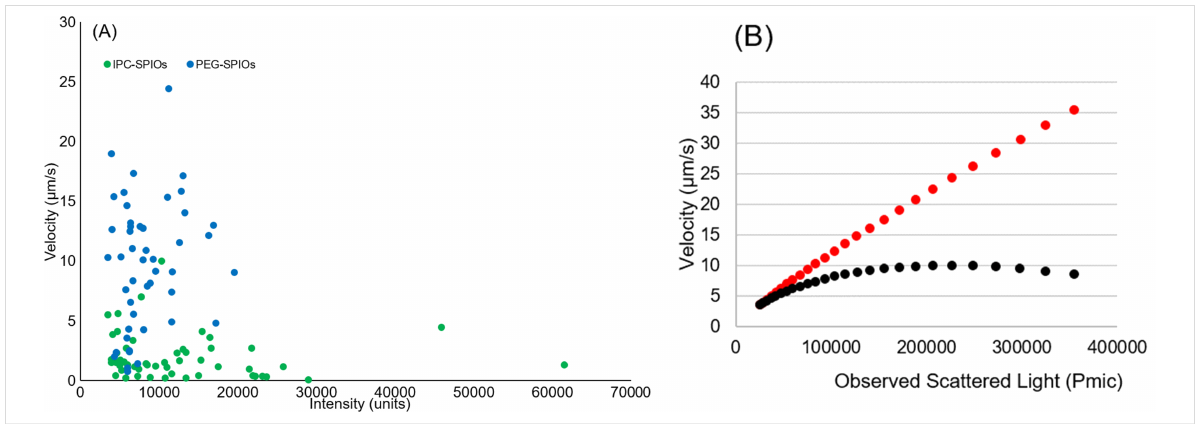
Figure 6: Velocity vs intensity. (A) Velocity of individual PEG- and IPC-coated SPIOs vs measured scattering intensity. (B) Predicted variation in the observed velocity for well coated (red) and poorly coated (black) particles from Equations 1–4 using γ = 0.2 nm − 1 , γ = 0.1 nm − 1 , and β = 0.01 nm − 1 used for well coated, poorly coated, and evanescent field,